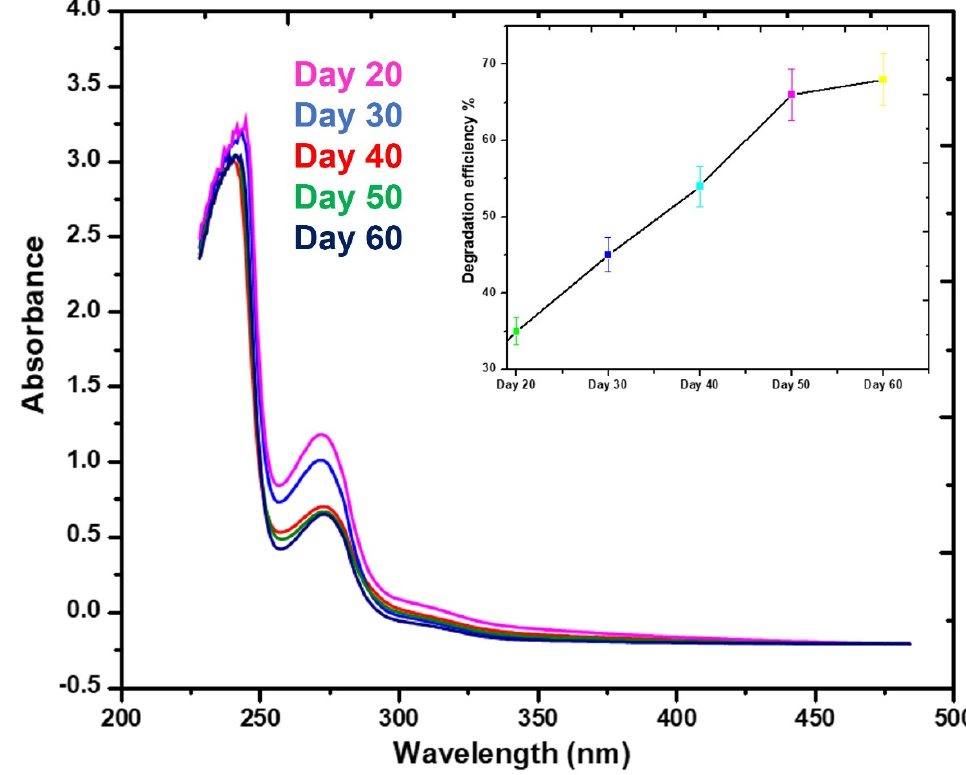
Figure 6. UV–visible curves of treated hydroquinone from MFC operation.